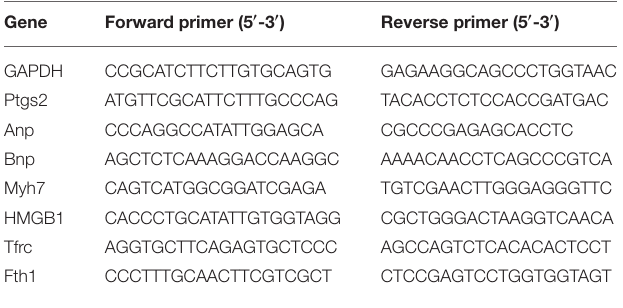
TABLE 1 | Sequences of primers used for real-time